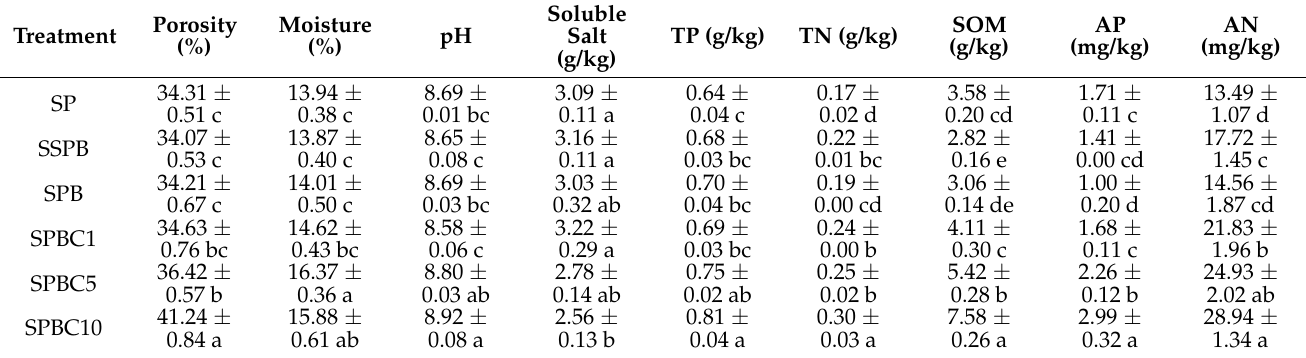
Table 1. Effects of single FB addition or the co-addition of biochar and FB on soil properties and